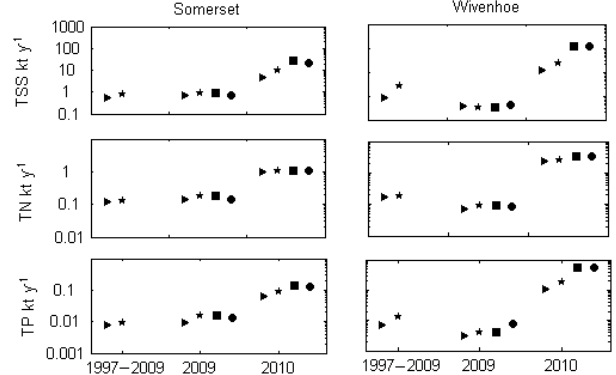
Figure 6. Comparison of four methods for calculating mean annual TSS, TN and TP output loads (kty − 1 ), using [TSS], [TN] and [TP] from 1. (cid:73) mean historical concentration of monthly monitoring data water years 1997–2010; 2. ∗ monthly monitoring, with missing data replaced by mean historical concentration; 3. (cid:4) monthly monitor- ing, with missing data replaced by concentrations estimated from turbidity profiles, and mean historical concentrations where turbid- ity data are unavailable; 4. • turbidity profiles, with missing data replaced by monthly monitoring, and mean historical concentration